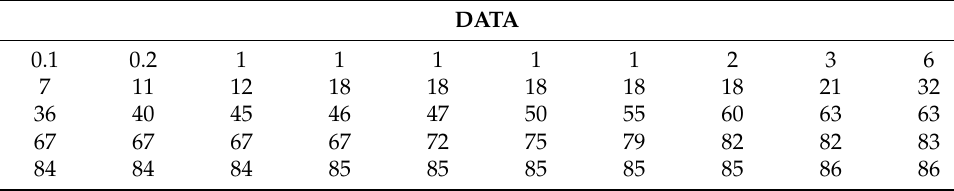
Table 2. Aarset Data of 50 Devices.